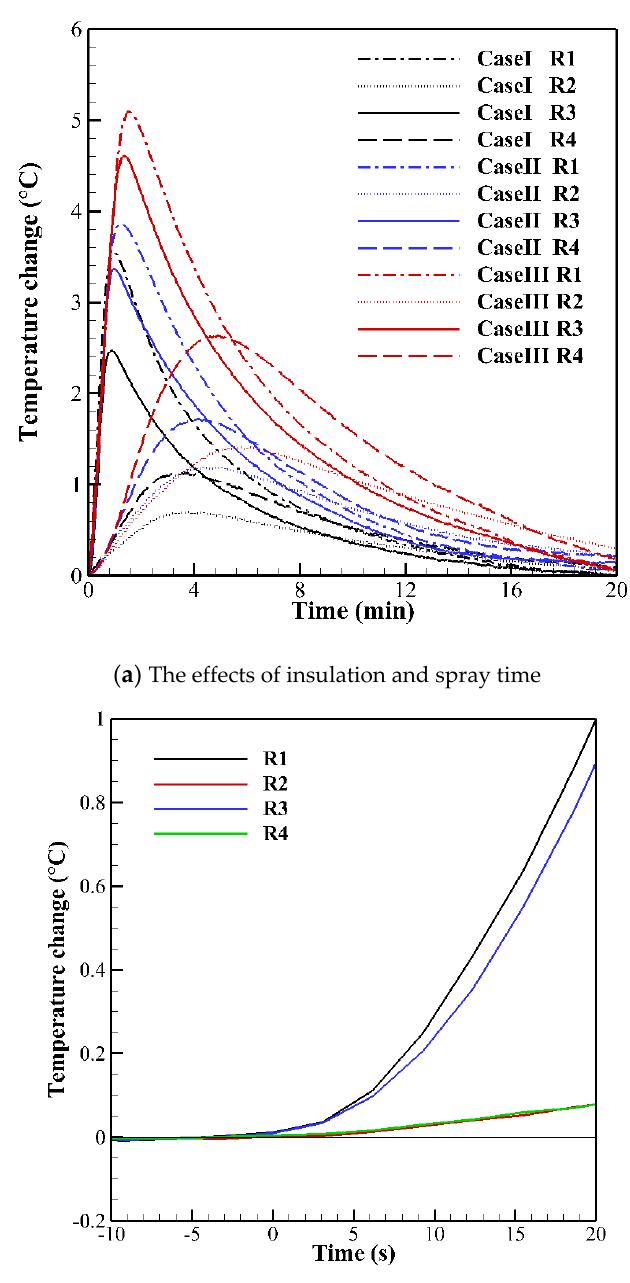
Figure 7. Response of R1-R4 to the first spray event of each test case.